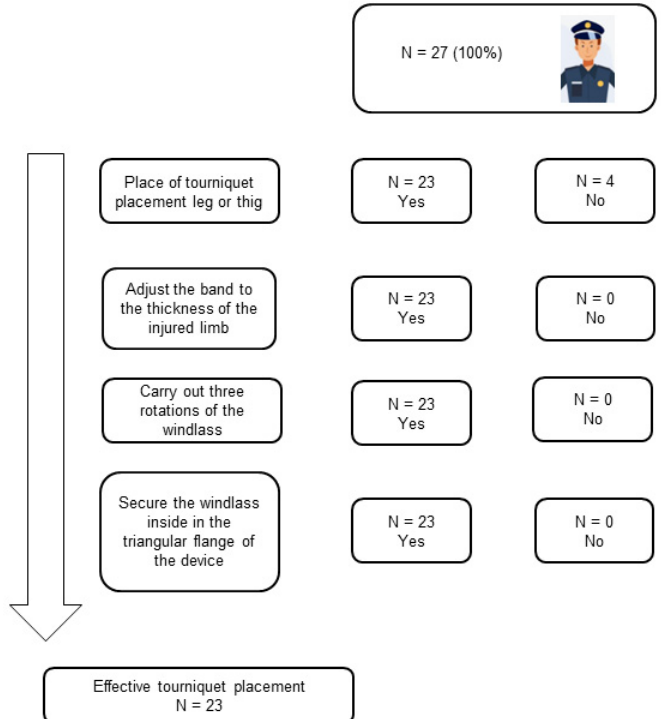
Figure 1. Effective Tourniquet Placement Flow Chart.